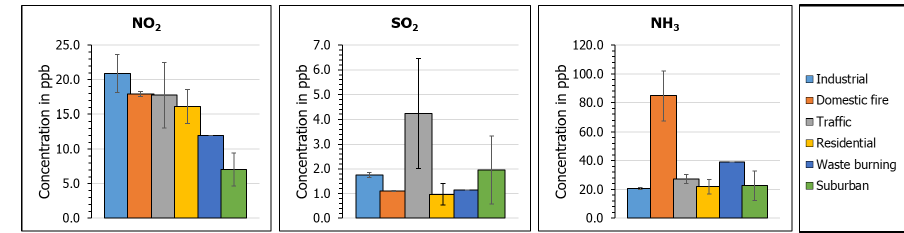
Figure 12. Concentration of gaseous pollutants by anthropogenic sectors of activity in the district of Abidjan.